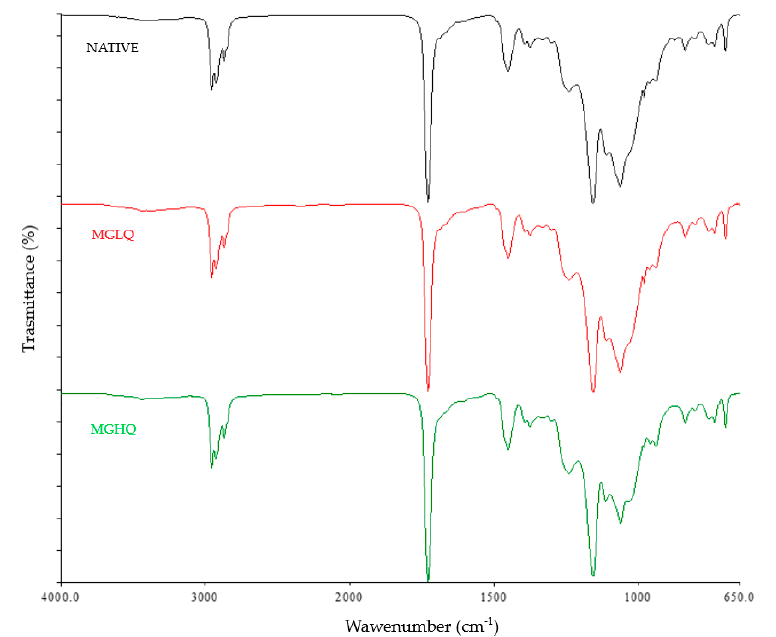
Figure 2. ATR–FTIR spectrum acquired for the native (black), MGLQ (red), and MGHQ (green) membranes.